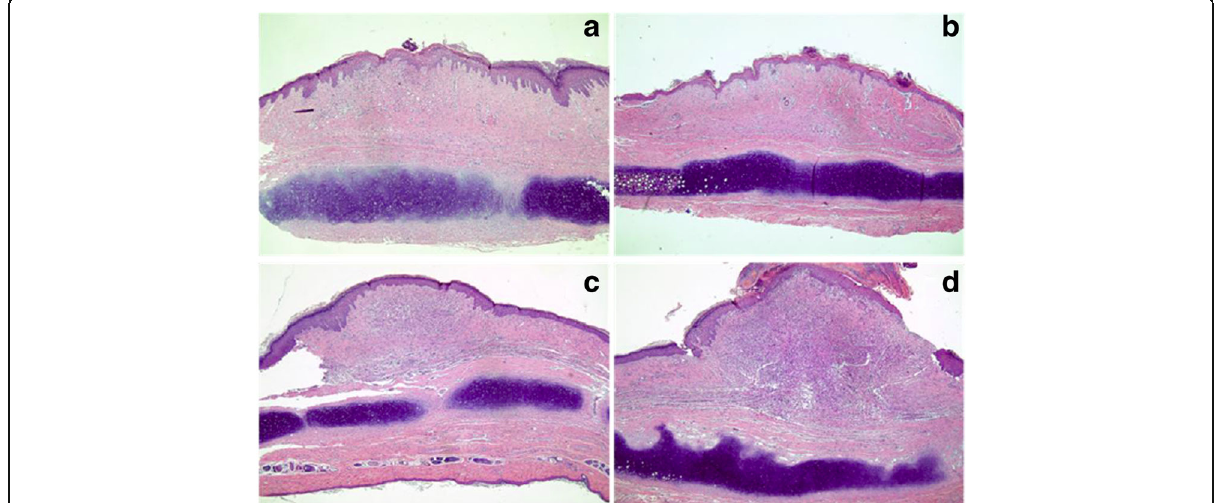
Fig. 7 H&E histological analysis of rabbit hypertrophic scars after applied different treatments for 7 days. The 5EL group: the enthosomal gels encapsulated with 5-FU combined with CO 2 fractional laser ( a ); CO 2 group: CO 2 fractional laser treatment ( b ); 5E group: the enthosomal gels encapsulated with 5-FU ( c ); and blank group: blank ( d ). Original magnifications: × 40